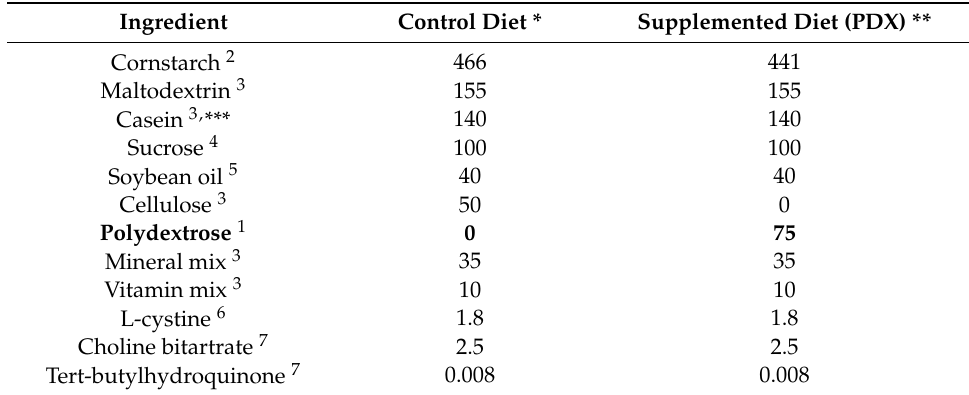
Table 1 . Composition of experimental diets (g/kg) in accordance with AIN-93M [38]. Table 1. Composition of experimental diets (g/kg) in accordance with AIN-93M [38]. Ingredient